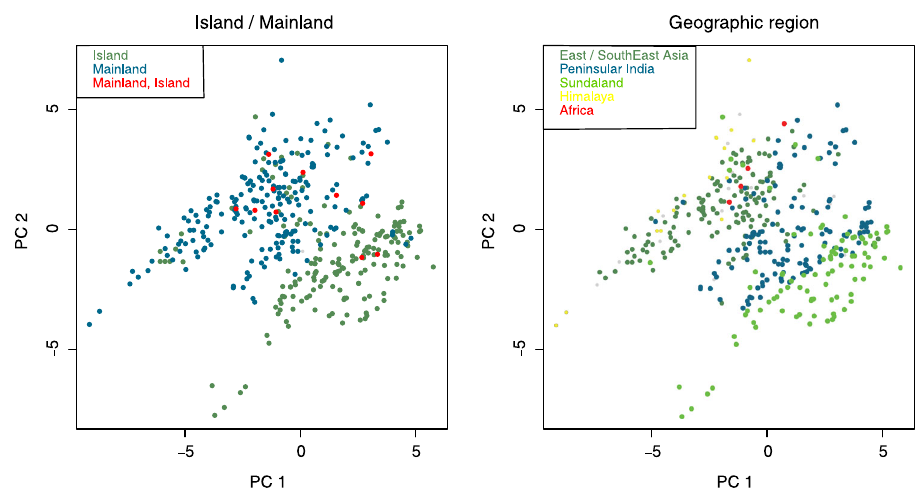
Fig. 3 Climatic space in Rhacophoridae de fi ned by the fi rst two principal component axes of climate niches. Each point represents the average climatic conditions of a single species. Loadings are provided in Supplementary Table 2. PC1 explains 40.5% of the variance and re fl ects variation in temperature; PC2 explains 23.9% of the variance and re fl ects variation in temperature and rainfall. Geographically, species in Sundaland are adapted to warm and less- seasonal climates, whereas species from East/Southeast Asia and Himalaya are cool-wet adapted. General patterns indicate that island species are comparatively warm-adapted while mainland species are more or less cool-wet